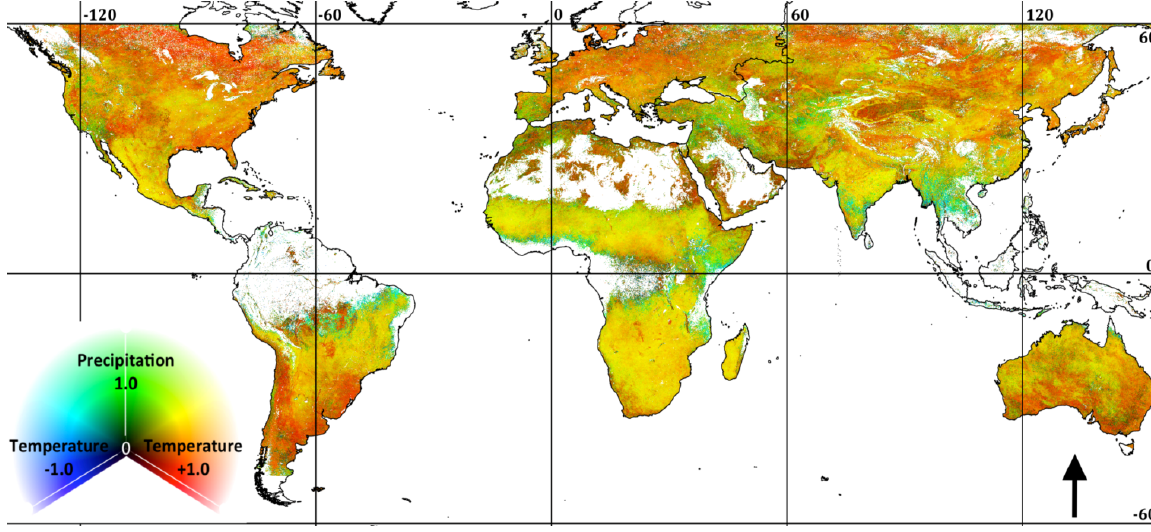
Table 1. Summary of precipitation and temperature mean correlation (Corr.) to